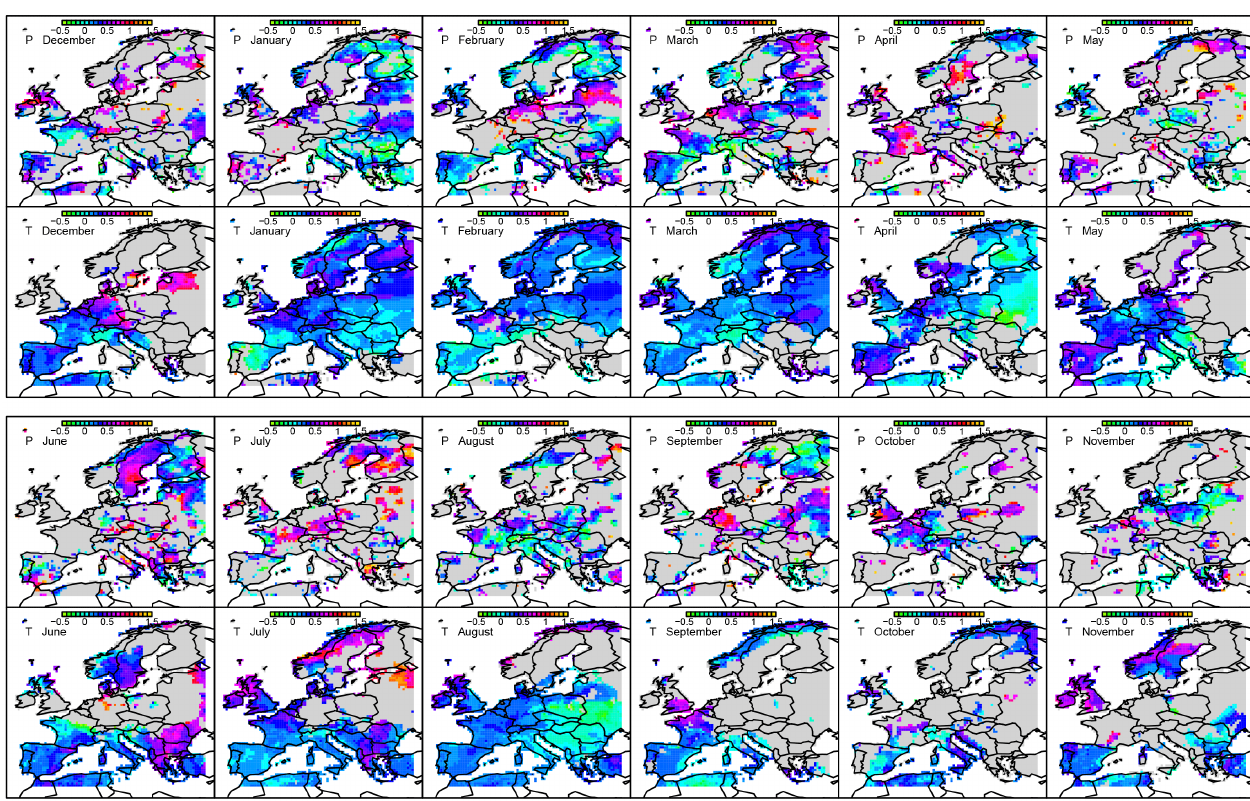
Figure 6. Monthly trend ratios for trends within the groups of wet STs for precipitation (rows 1 and 3) and temperature (rows 2 and